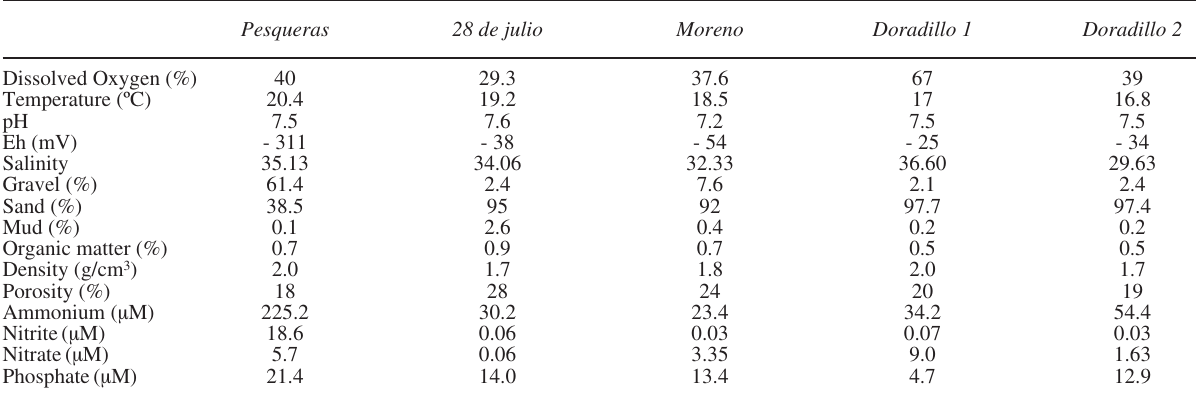
Table 3. – Environmental variable values in the lower